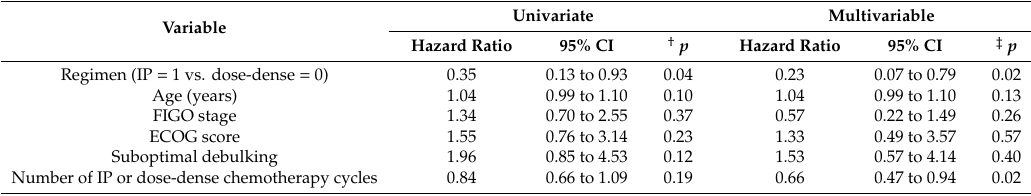
Abbreviations are the same as Table 2. † Univariate Cox proportional-hazards model. ‡ Multivariable Cox proportional-hazards model.